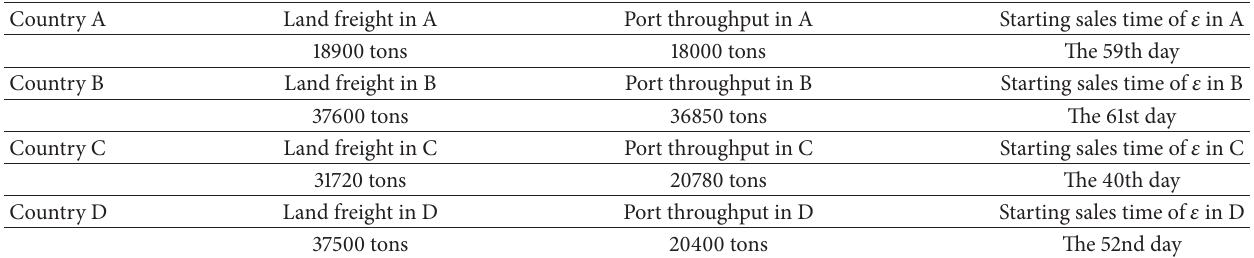
Table 10: Simulation results of freight volume and period in Scheme